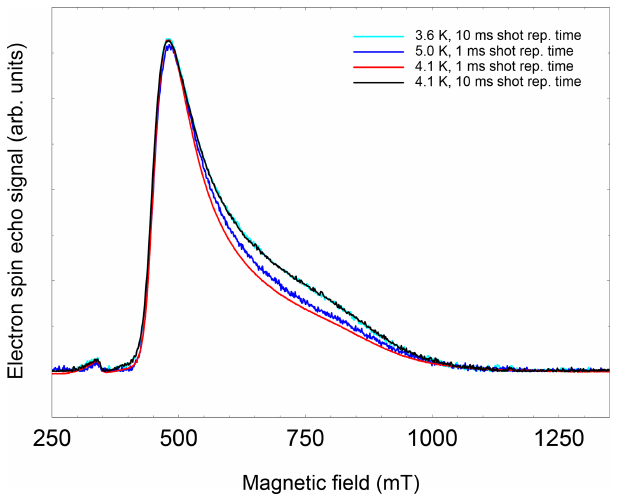
Figure A4. 9.7GHz FSE spectra of NO@C60-OH3 measured at 3.6, 4.1, and 5K. Using a rather short pulse repetition time (1ms), the high-field part of the spectrum is partially saturated.